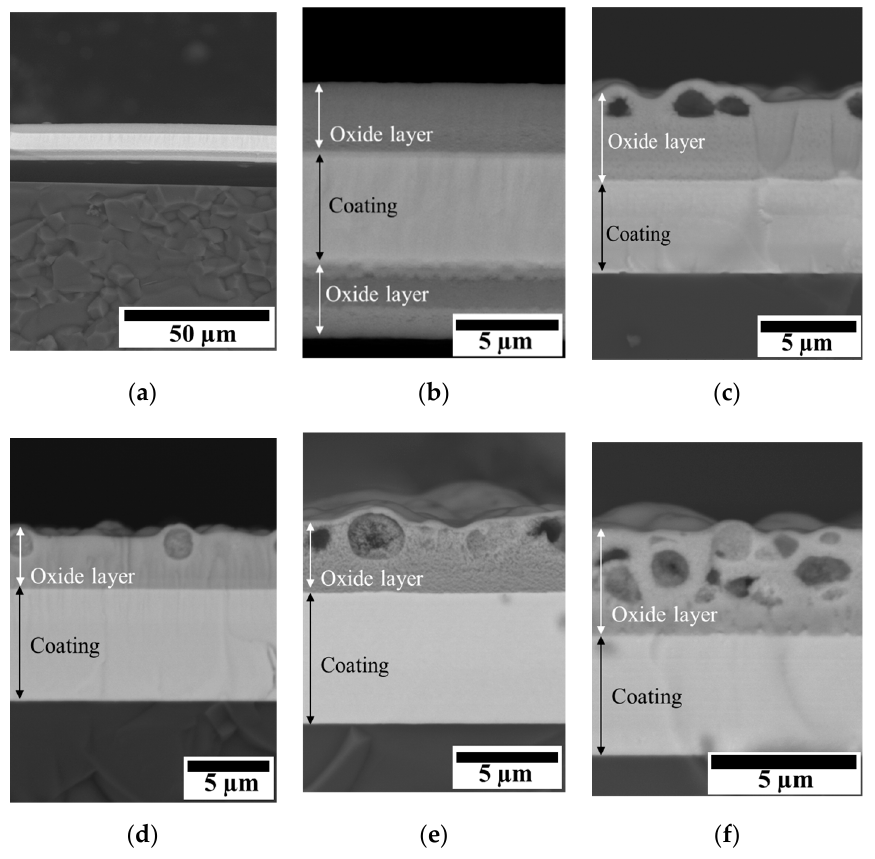
Figure 7. Cross-section SEM images of coatings 1 (Ar) ( a , b ), 2 (5 sccm N 2 ) ( c ), 3 (10 sccm N 2 ) ( d ), 4 (5 sccm C 2 H 4 ) ( e ), and 5 (10 sccm C 2 H 4 ) ( f ) after air annealing with maximal temperature of 1000